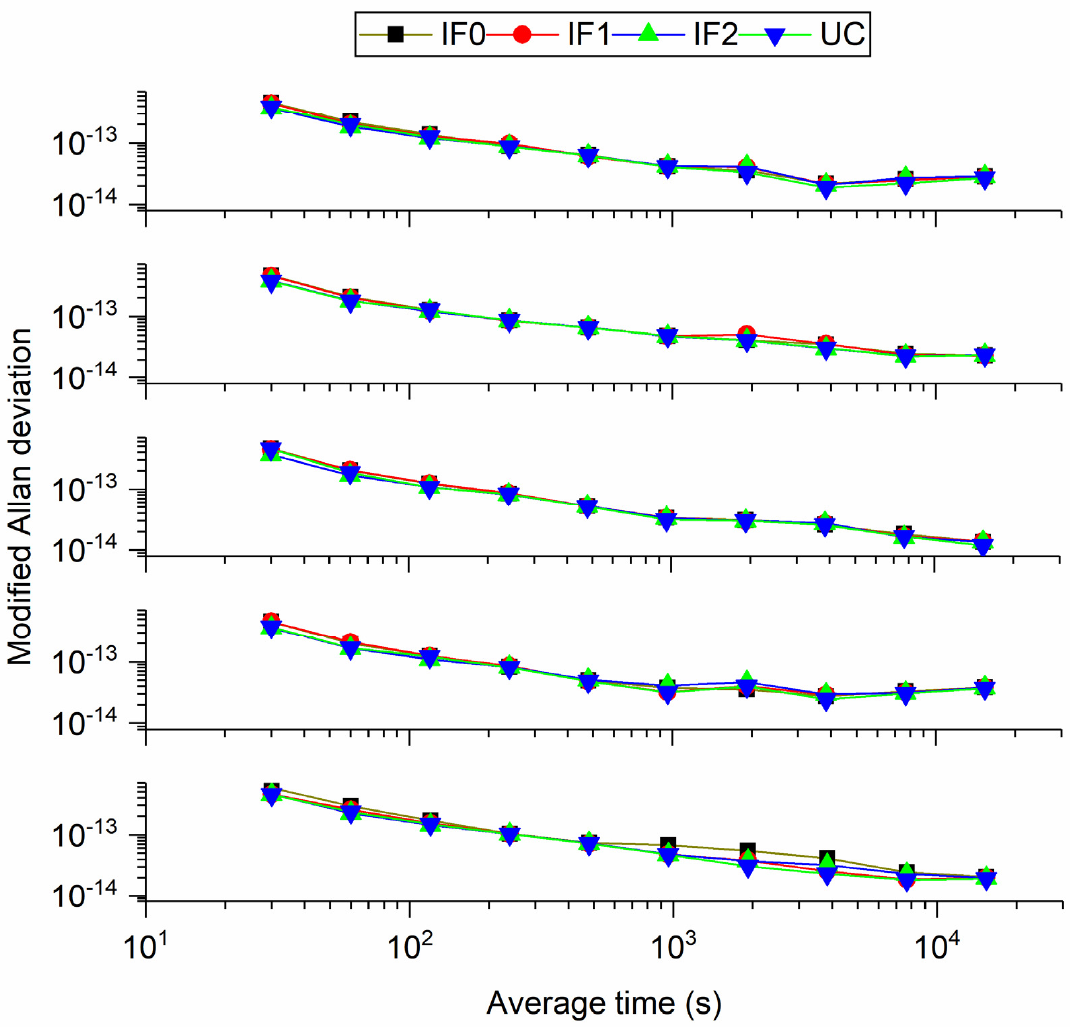
Figure 5. Comparison of MDEV between different BDS-3 PPP models from DOY 15 to 19 on XIA3-BRCH time-link.